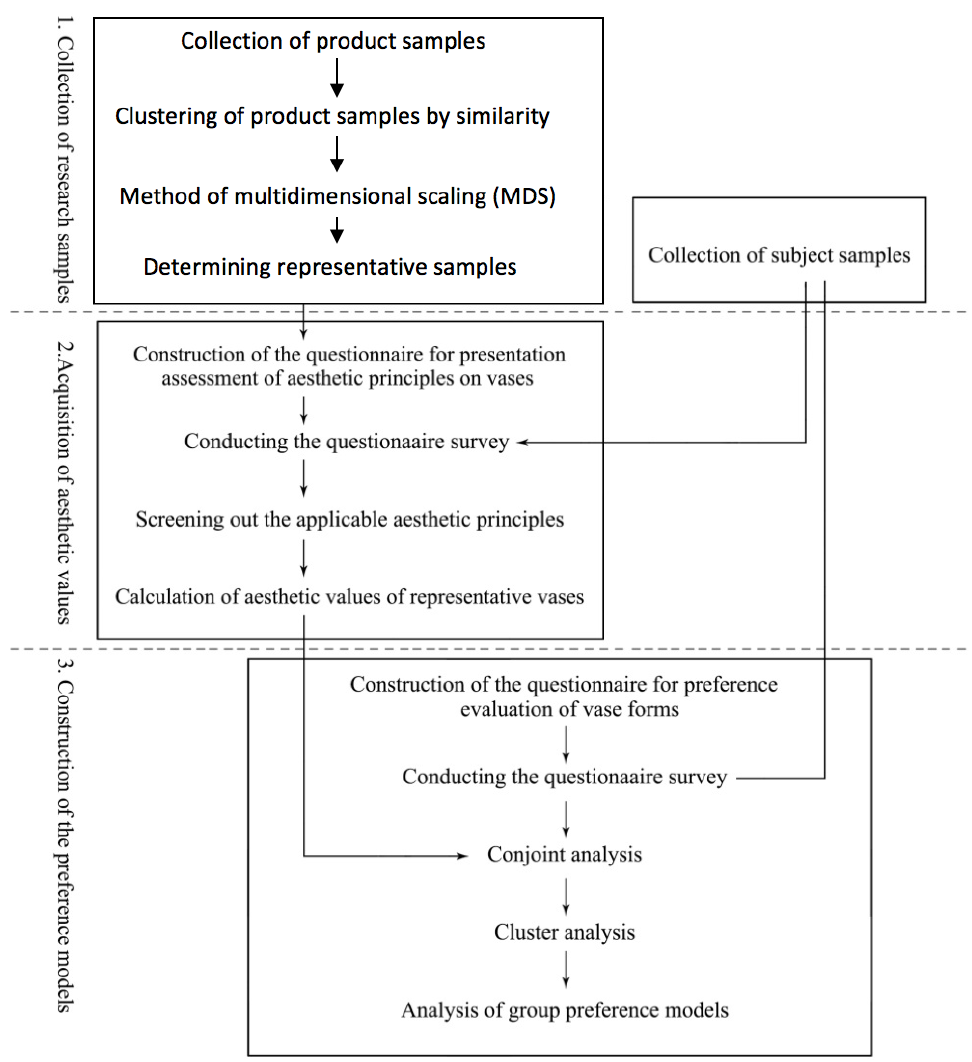
Figure 4. Flowchart of research process.